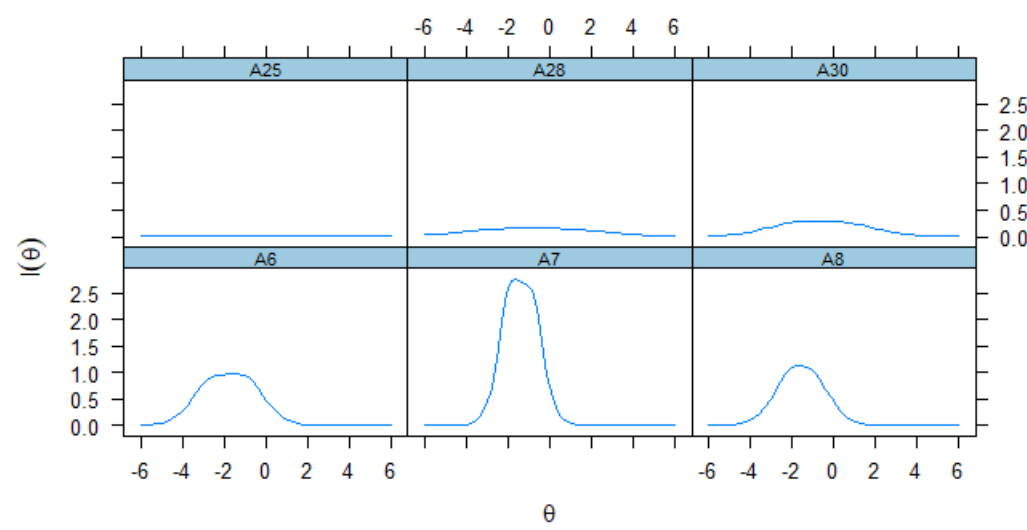
Figure 3. TICs of the Inner Peace and Family Support Needs component.